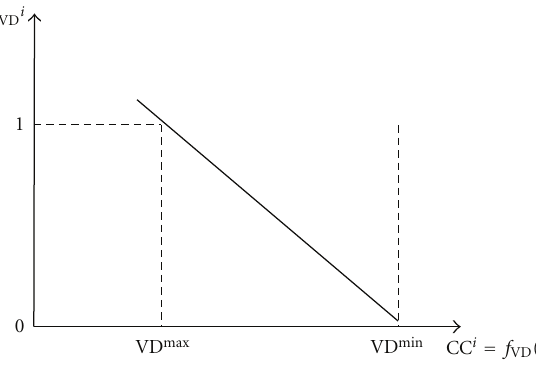
Figure 3: Fuzzy model of voltage